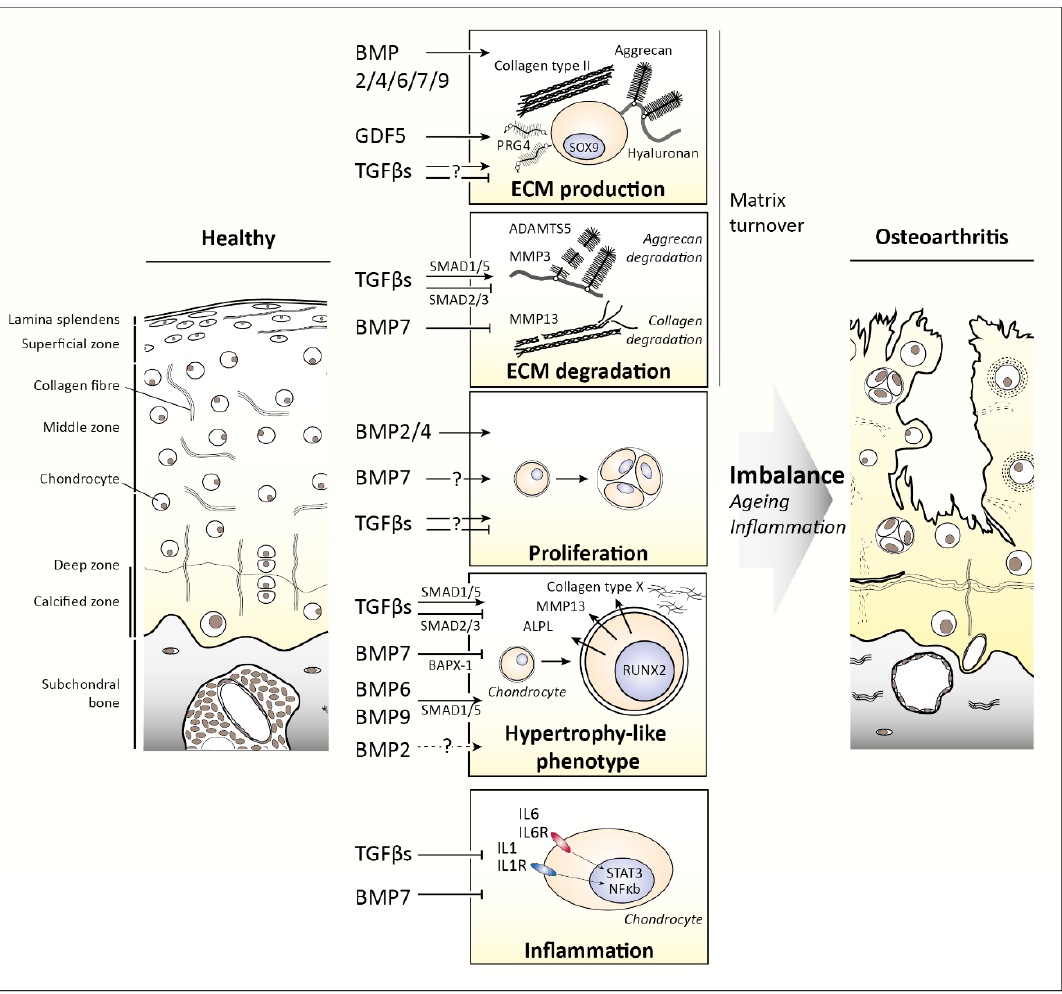
Figure 4. Effects of the different Transforming Growth Factor β (TGFβ) family members on articular cartilage biology and osteoarthritis (OA) development. On the left healthy articular cartilage is depicted, on the right osteoarthritic cartilage. The middle depicts how TGFβ family members reg ulate matrix turnover, chondrocyte proliferation, hypertrophy-like differentiation, and inflammation. An imbalance in these effects of TGFβ family members because of age - and/or inflammation-related changes contributes to OA development. ADAMTS5 = A disintegrin and metalloproteinase with thrombospondin motifs 5, ALPL = Alkaline phosphatase tissue-nonspecific isozyme, BAPX-1 = Homeobox protein Nkx-3.2, BMP = Bone morphogenetic protein, GDF = Growth differentiation factor, IL = interleukin, MMP = matrix metal loproteinase, NFκb = nuclear factor kappa -light-chain-enhancer of activated B cells, PRG4 = proteoglycan 4, RUNX2 = Runt-related transcription factor 2, SOX9 = Transcription factor SOX-9 , and STAT3 = Signal transducer and activator of transcription 3.